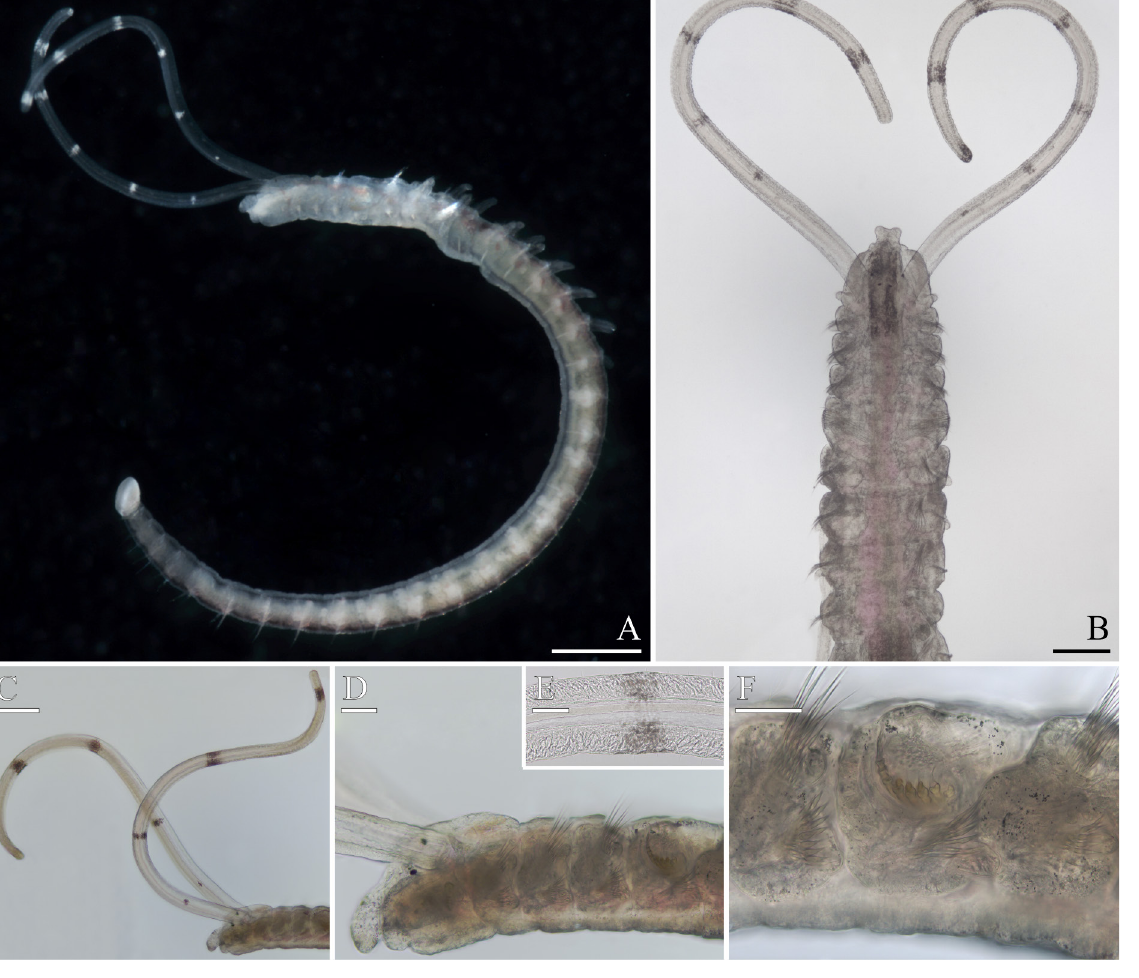
Fig. 12. Adult morphology of Pseudopolydora kuwaiti sp. nov. (live individuals, MIMB 40713). A . Left lateral general view, female, in reflected light, showing white chromatophores on palps. B–D . Anterior ends, in transmitted light, dorsal (B) and left lateral (C–D) view. E . Fragment of palp with chromatophore and inner blood vessel. F . Chaetigers 4–6, left lateral view, showing curved diagonal row of heavy spines in notopodium of chaetiger 5. Abbreviations: ho = hooded hooks; no = notopodial postchaetal lamella; pe = pennoned capillary notochaetae; su = dorsal superior capillary chaetae; ve = ventral capillary chaetae. Scale bars: A = 200 µm; B–D = 50 µm; E = 20